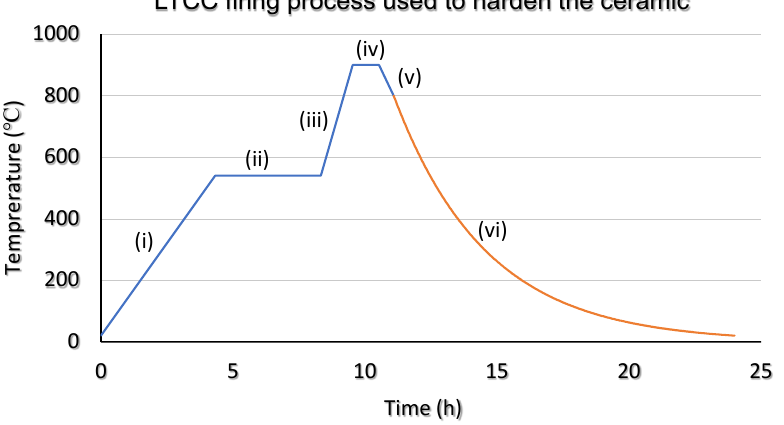
Figure 3. LTCC firing process used in the formation of Cl 2 gas sensor transducer. Using a firing temperature of 900 ◦ C, several devices were fabricated with fully functioning substrate heaters and temperature sense layers (Figure 4). Any successfully fired ceramic device turned a deep green color and shrunk by 18 ± 2% from its original size in line with the manufacturer’s specification. That was taken care of at the CAD design level by increasing the dimensions of the printed layers by 18%.